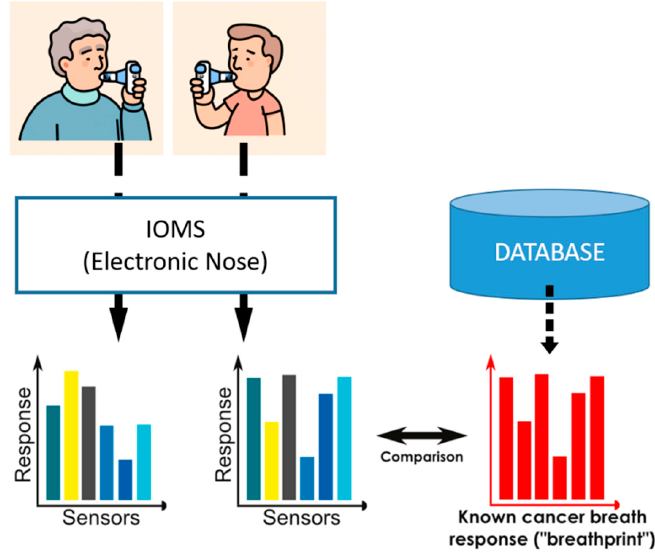
Scheme 1. Breathprint disease recognition principle using an